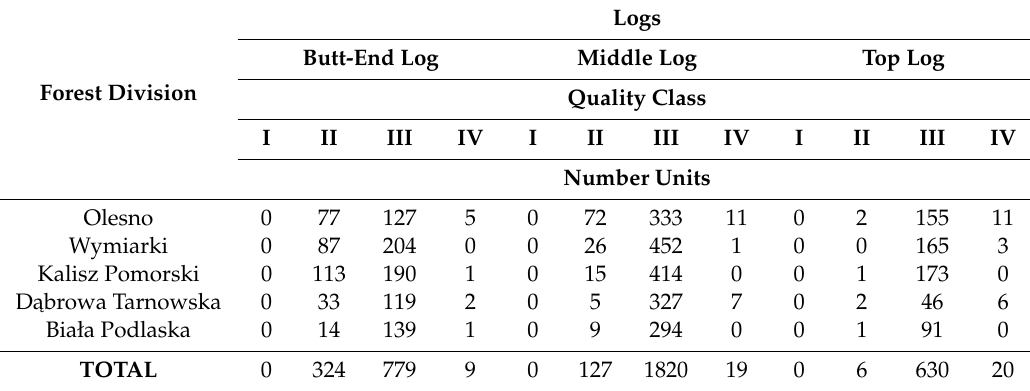
Table 5. Amount of sawn timber by defect: knots (PN-75 / D-96000).